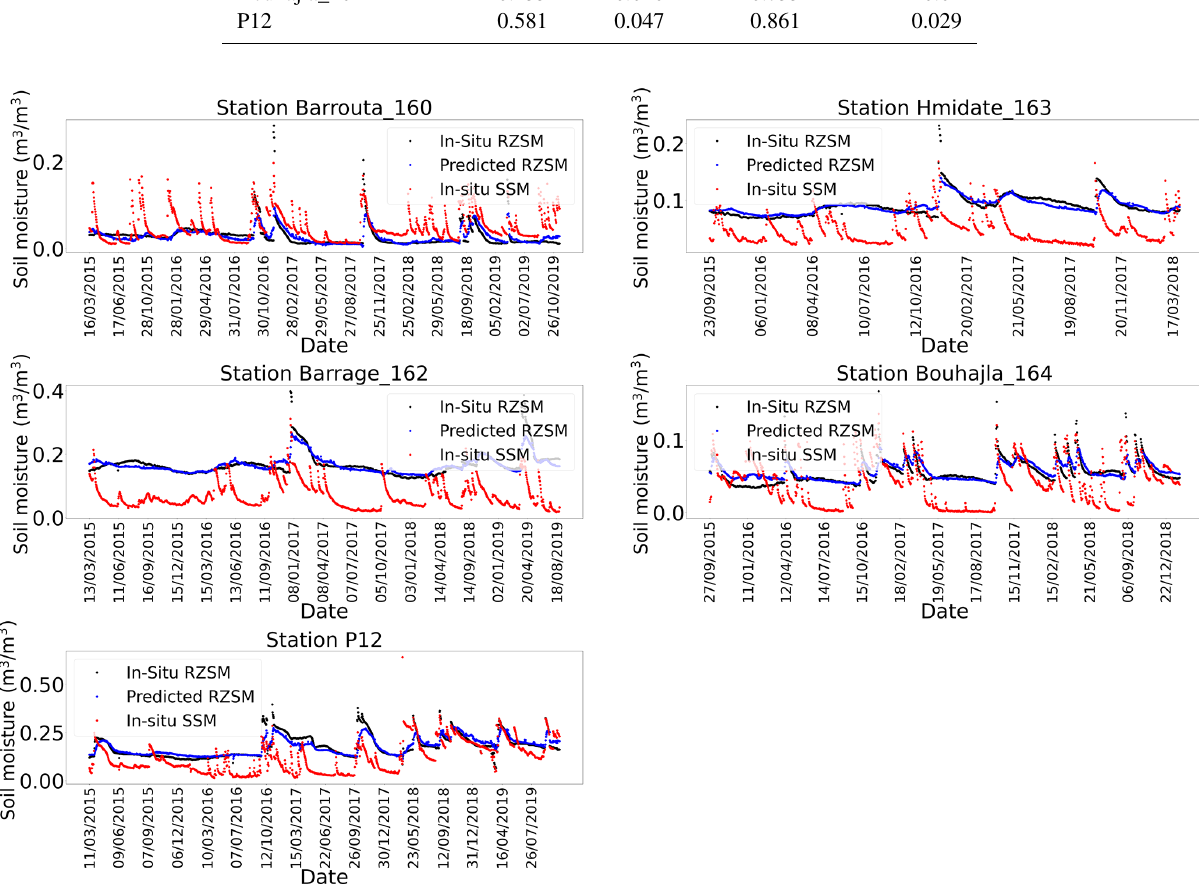
Figure 4. In situ SSM, in situ RZSM, and predicted RZSM series at the stations in the Kairouan Plain (Tunisia) with model ANN_SSM_NDVI_EVAP-EFF-B60_EXP-FILT-T5 (see Appendix G for a larger figure format).